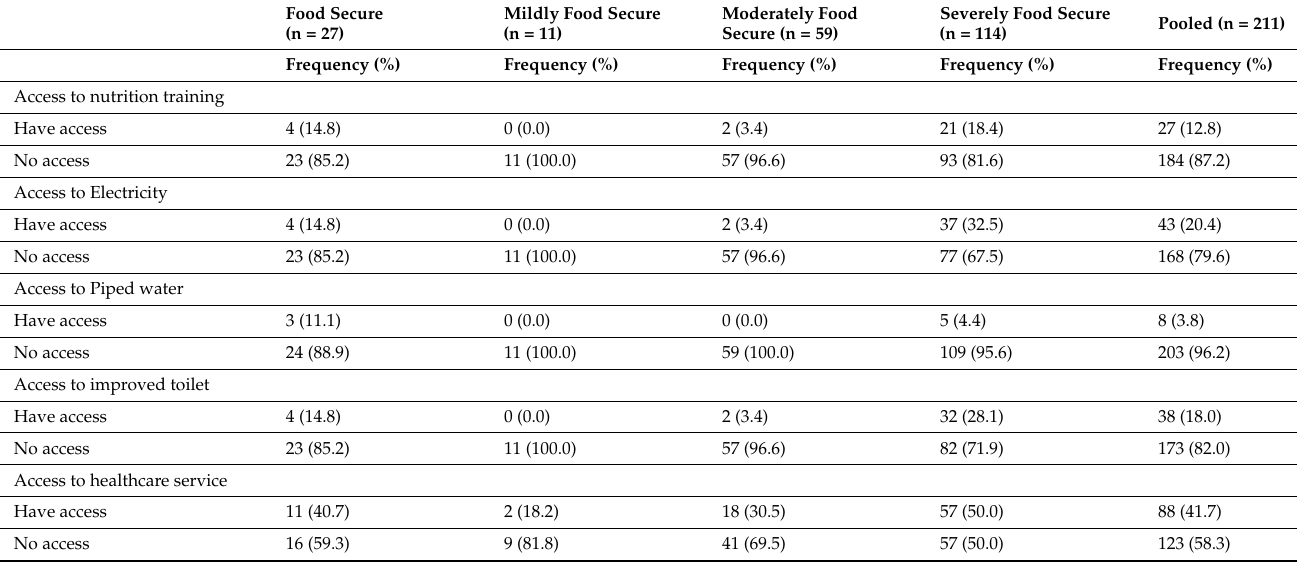
Table 8. Distribution of environment and health-related factors of farming households according to food insecurity category. Food Secure Mildly Food Secure (n = 27) (n =